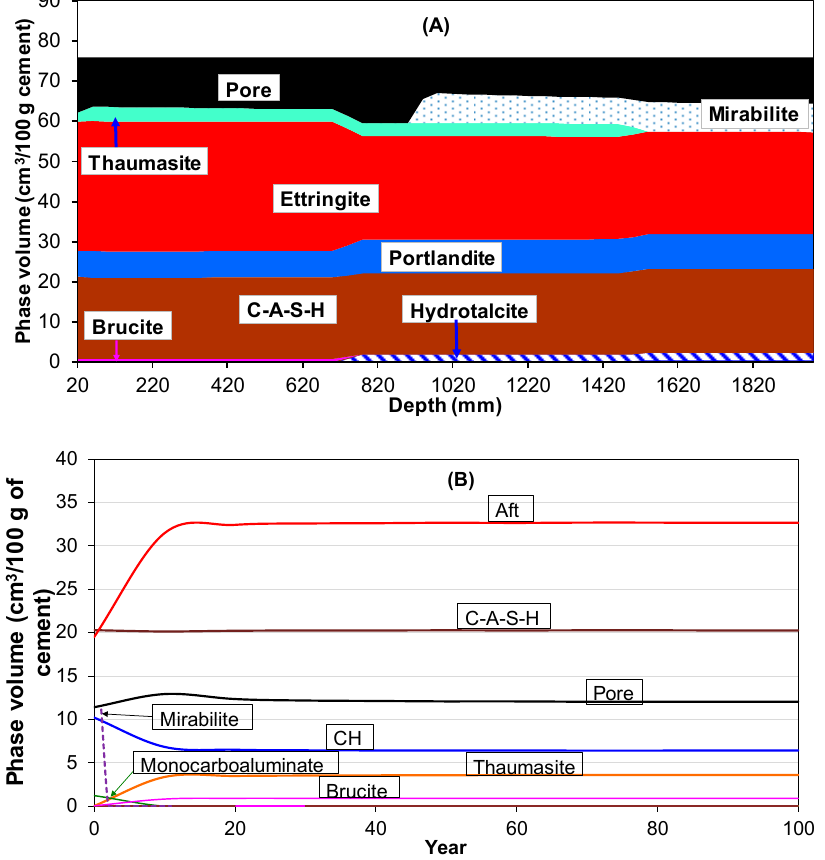
Figure 9. PC exposed to 10% of Na 2 SO 4 for 1000 years: ( A ) Phase changes after 1000 years; ( B ) phase changes at 100 mm from the exposure surface.